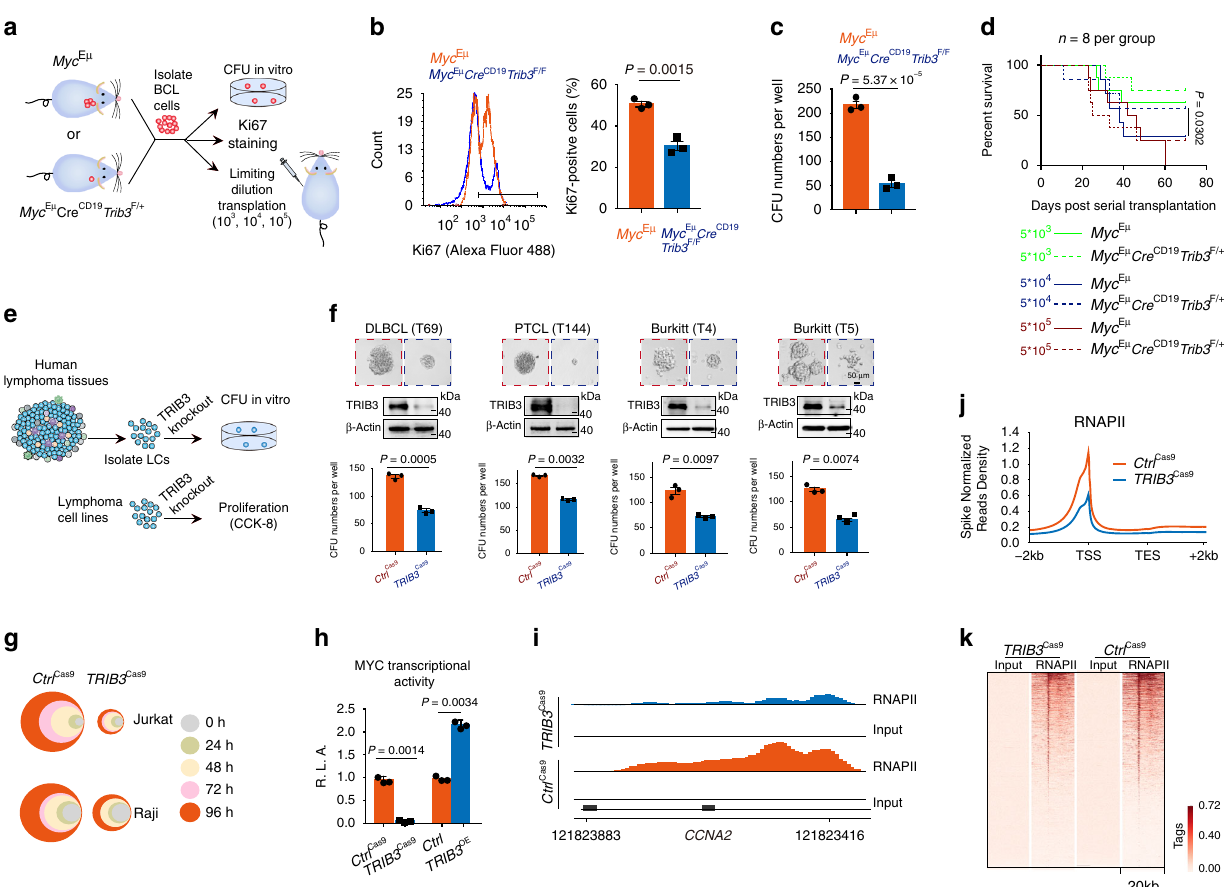
Fig. 2 TRIB3 enhances the self-renewal and proliferation of LCs. a Approaches to de fi ning self-renewal ability and proliferation in mouse BCL cells. b Cell proliferation was determined by Ki67 staining in BCL cells isolated from Myc E μ or Myc E μ Cre CD19 Trib3 F/F mice (5 months old). Data are representative fl ow cytometry plots of Ki67 staining (left) and means ± S.E.M of three independent experiments. Statistical signi fi cance was determined by two-tailed Student ’ s t test. P value: 0.0015. c Colony-forming ability of BCL cells from Myc E μ or Myc E μ Cre CD19 Trib3 F/F mice (5 months old). Shown is means ± S.E.M of three independent experiments. Statistical signi fi cance was determined by two-tailed Student ’ s t test. P value: 5.37 × 10 − 5 . d The tumorigenicity of BCL cells from the indicated mice was compared by limiting dilution transplantation into NSG mice; n = 8 mice per group. P = 0.0302 by Kaplan – Meier analysis (two- sided log-rank test) for comparison between the groups of the transplantation cell dose of 5 × 10 4 . e Approaches to de fi ning the effects of TRIB3 deletion on the self-renewal ability of primary human LCs and on the proliferation of lymphoma cell lines. f Representative images and colony numbers of LCs from the indicated groups with or without TRIB3 deletion Data are presented as the means ± S.E.M from three independent experiments. Statistical signi fi cance was determined by two-tailed Student ’ s t test. P value: 0.0005, 0.0032. 0.0097, and 0.0074. Scale bar, 50 μ m. g Relative cell viabilities of Jurkat and Raji cells with or without TRIB3 deletion were detected by CCK-8 for the indicated times of three independent experiments. The colors represent different time points; the diameter indicates the relative cell viability. h Effects of TRIB3 deletion or overexpression on the transcriptional activity of MYC. Ctrl Cas9 , TRIB3 Cas9 , Ctrl , and TRIB3 OE Raji cells were transfected with E-box-dependent luciferase reporter genes of MYC transcription activity, and pTK-Renilla was used as an internal control. After 24 h of transfection, relative luciferase activities (R.L.A) were measured. Shown is means± S.E.M of three independent experiments. Statistical signi fi cance was determined by two-tailed Student ’ s t test. P value: 0.0014, 0.0034. i ChIP-sequencing tracks for CCNA2 from Ctrl Cas9 and TRIB3 Cas9 Raji cells normalized to spike-in controls. j Metagene plots of global RNAPII occupancy at gene bodies in Ctrl Cas9 and TRIB3 Cas9 Raji cells. k Heatmap showing occupancy of genome-wide RNAPII peaks in Ctrl Cas9 and TRIB3 Cas9 Raji cells in a window of ±10 kb surrounding the transcription start site (TSS). Myc E μ Cre CD19 Trib3 F/ + and Myc E μ Cre CD19 Trib3 F/F are heterozygous for the Myc E μ allele. Source data are provided as a Source Data fi